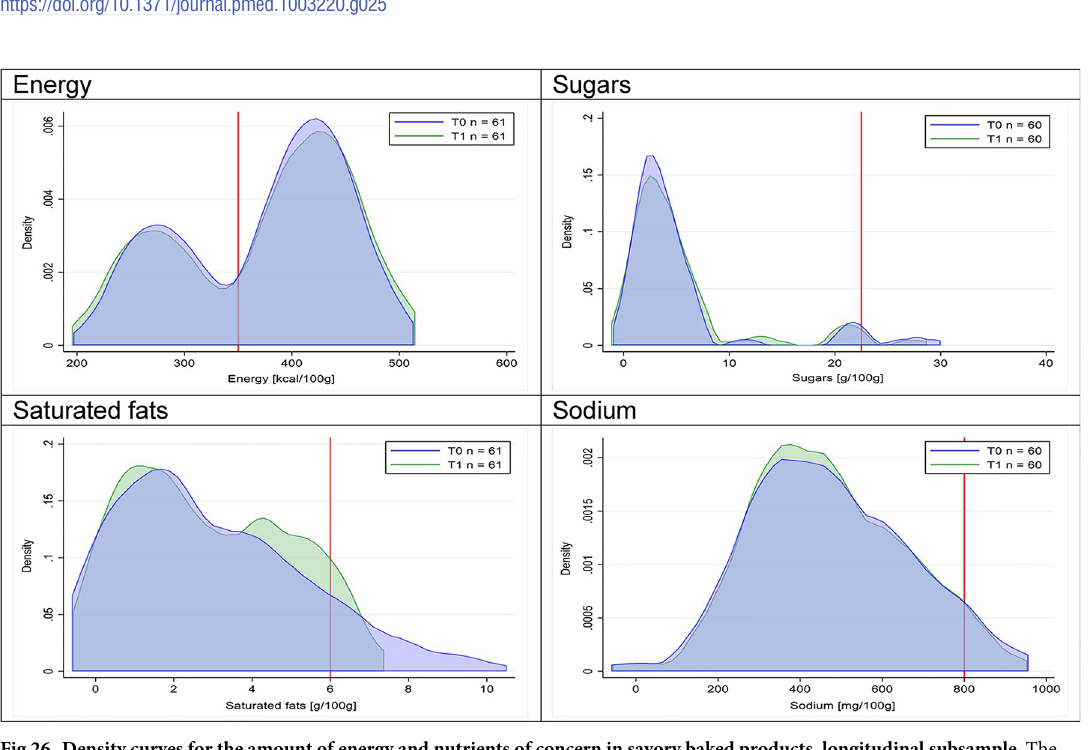
Fig 26. Density curves for the amount of energy and nutrients of concern in savory baked products, longitudinal subsample. The blue line represents the distribution in T0 (preimplementation), the green line represents the distribution in T1 (postimplementation), and the red line represents the cutoff for the amount of energy or nutrients of